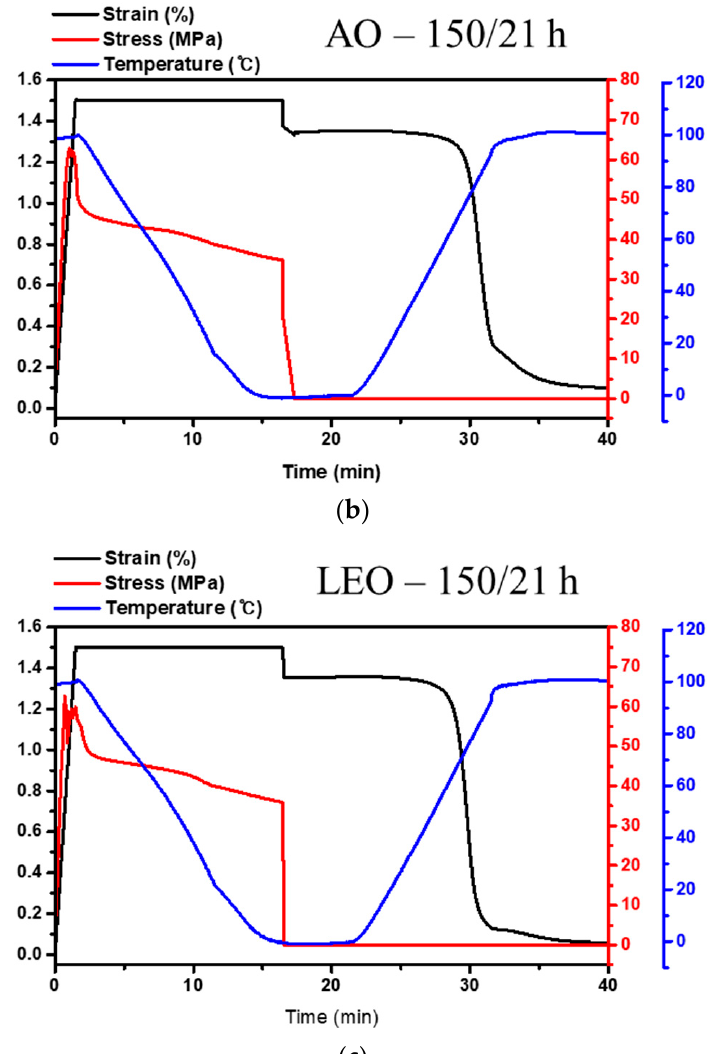
Figure 10. Shape memory properties of CF-SMPCs: ( a ) unexposed, ( b ) 150/21 h under an AO environment, and ( c ) 150/21 h under a LEO environment (for the shape memory properties of AO- and LEO-exposed CF-SMPCs, see Figures S1 and S2 in the Supplementary Information). Table 5. Shape memory properties of unexposed and AO and LEO-exposed CF-SMPCs. AO, LEO — Exposure Fixity Ratio (%) Recovery Ratio (%) 88 ±